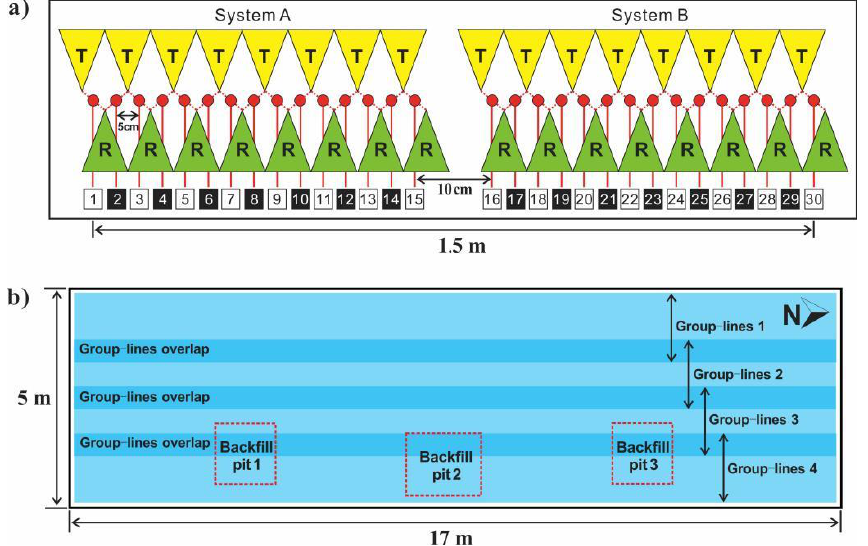
Figure 1. Overview of the experimental area. Table 1. TLFC 3D GPR data acquisition parameters.